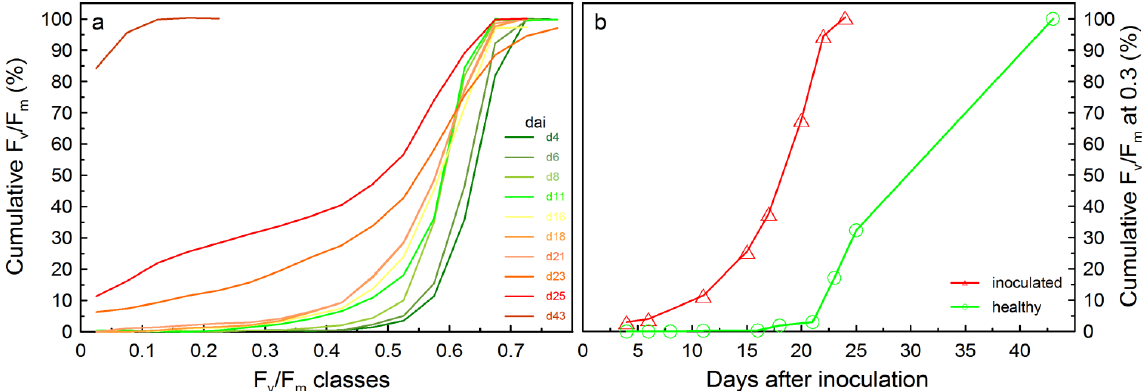
/F of a healthy wheat head during v m